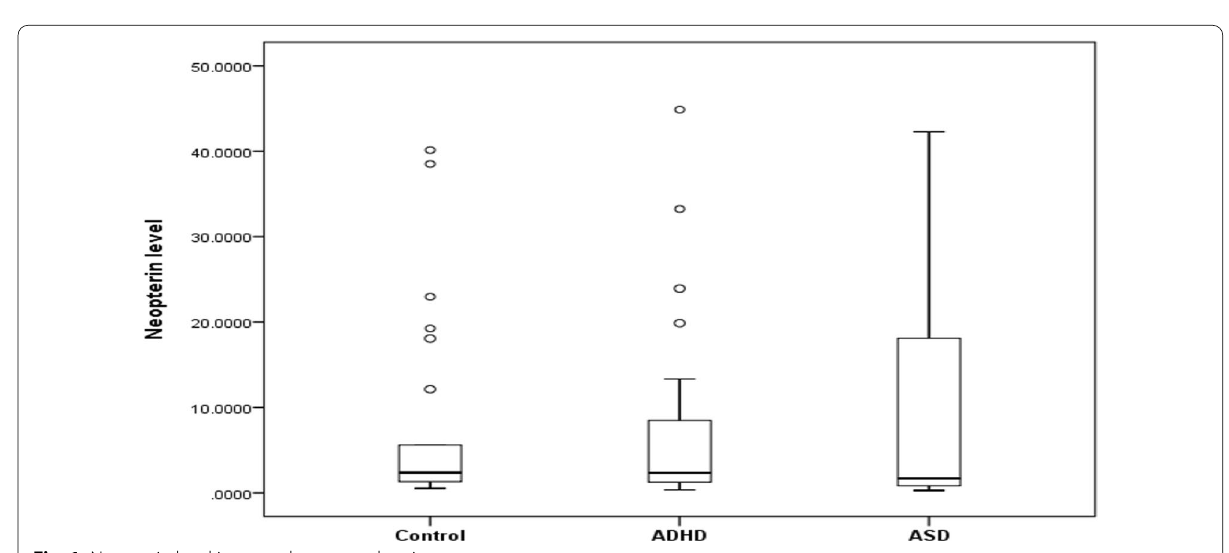
Fig. 1 Neopterin level in control group and patient groups